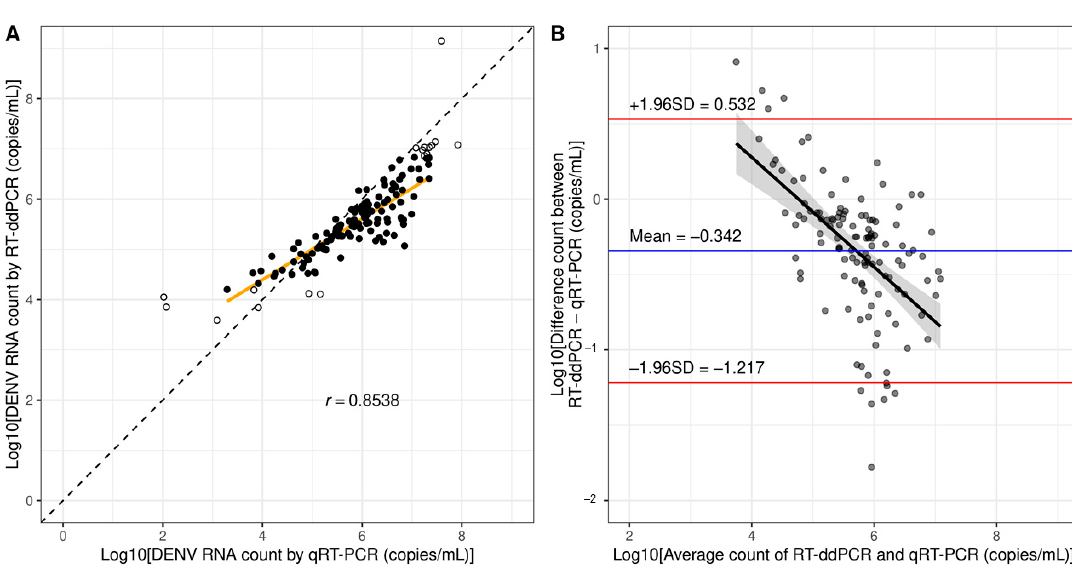
Figure 4. Comparison of quantification results between RT-ddPCR and qRT-PCR. ( A ) A regression line (orange) shows the correlation between dengue RNA from clinical samples measured by qRT-PCR and ddPCR. The diagonal line represents a hypothetical trend where results by the two methods are identical. The solid dots represent measured counts within the limit of quantification. The open dots represent measured counts below LLOQ or above ULOQ which were not included in the analysis. ( B ) Bland–Altman plot shows the limit of agreement between qRT-PCR and RT-ddPCR (red lines). The horizontal blue line shows the mean difference between the two methods (bias). A linear regression line and a confidence area show an association between measured counts and bias.